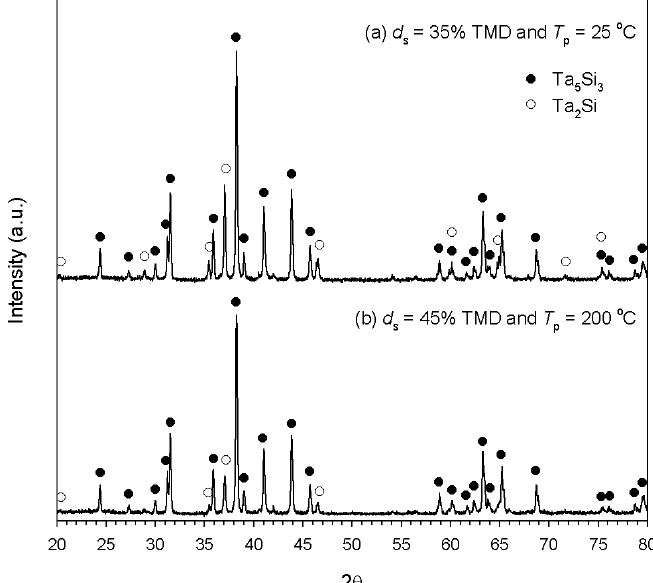
Figure 5. X-ray diffraction (XRD) patterns of SHS-derived products from Ta:Si = 5:3 powder compacts with ( a ) d s = 35% TMD and T p = 25 °C and ( b ) d s = 45% TMD and T p = 200